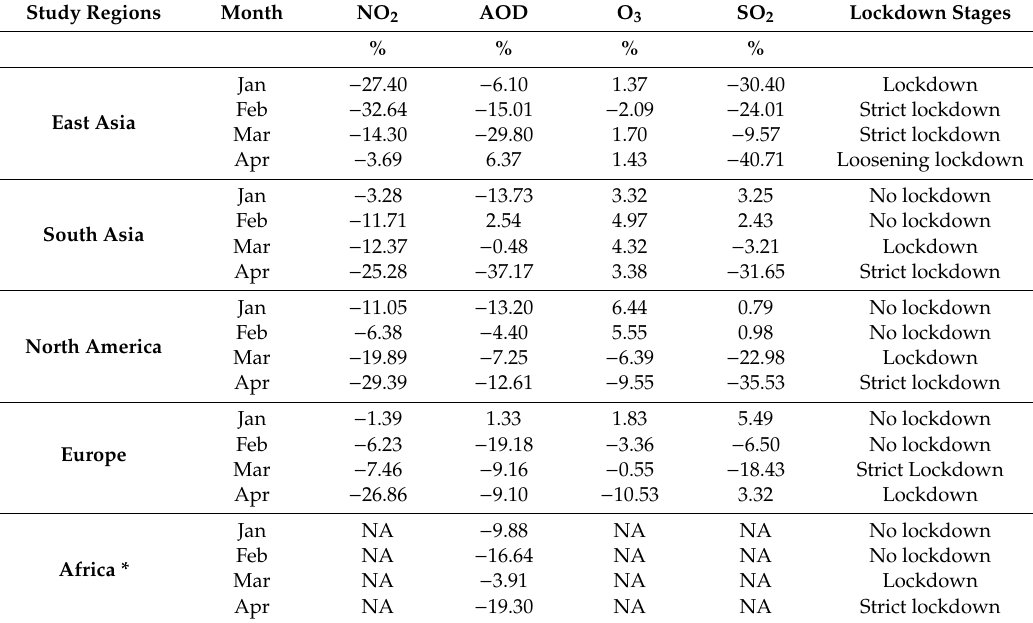
Table 2. Percentage reduction of NO 2 , AOD, O 3 , and SO 2 when comparing the level of 2020 during lockdown period with the baseline (the same period in 2015–2019). (*: Since other parameters for Africa have no significant change, they were skipped in this study. Only AOD was provided as significant changes of AOD occurred in